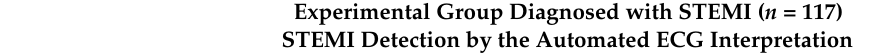
Table 1. Baseline characteristics of the experimental group.